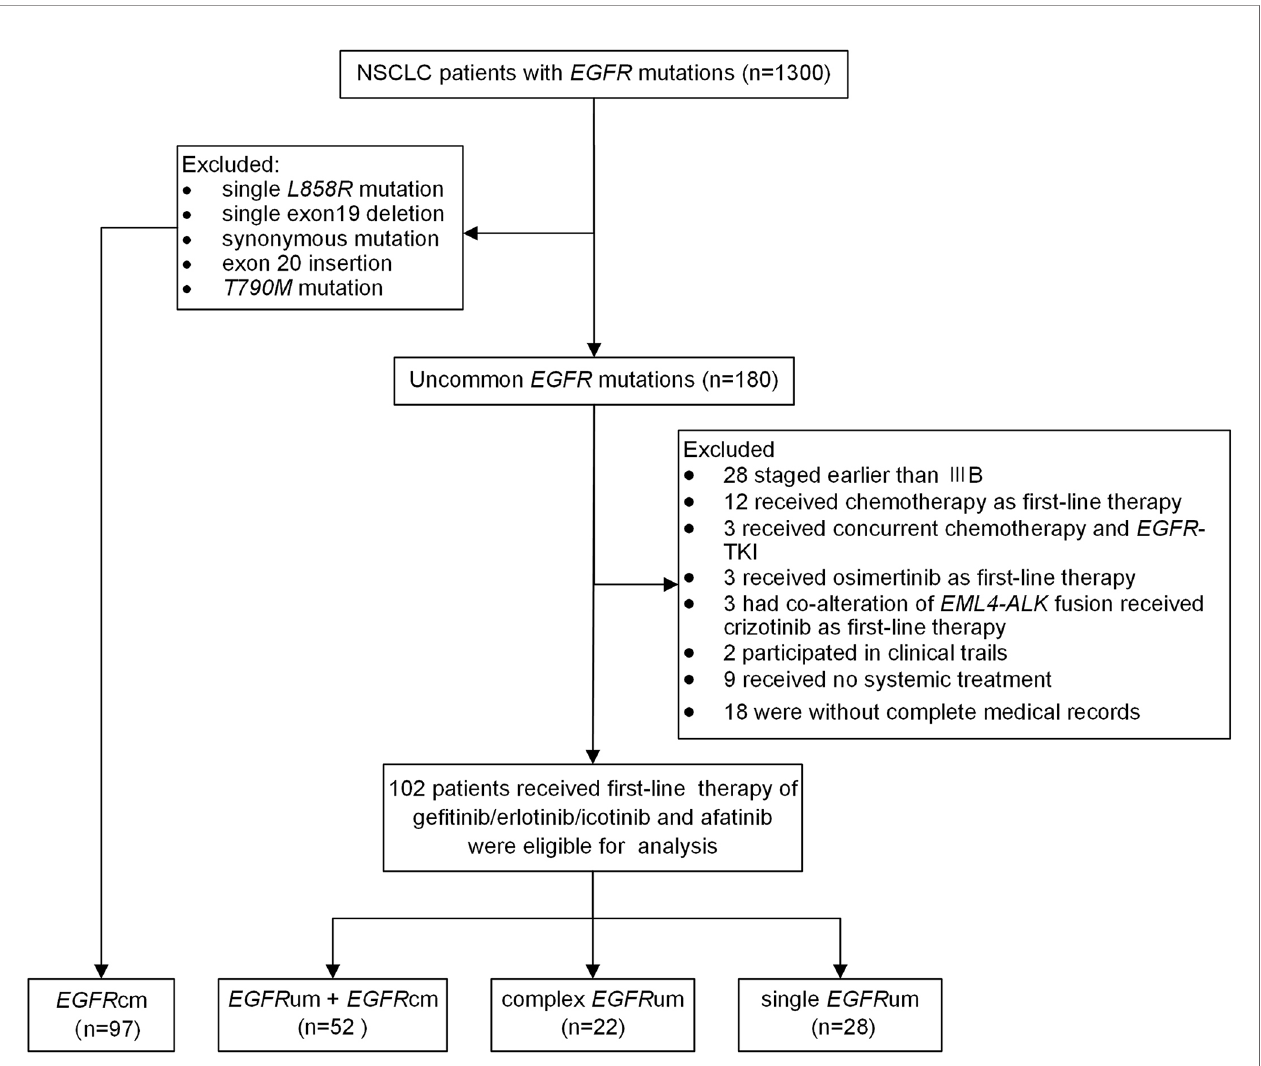
FIGURE 1 | The fl ow chart for patient inclusion. NSCLC, non-small cell lung cancer; EGFR , epidermal growth factor receptor; TKI, tyrosine kinase inhibitor; EGFR cm, common EGFR mutations; EGFR um, uncommon EGFR